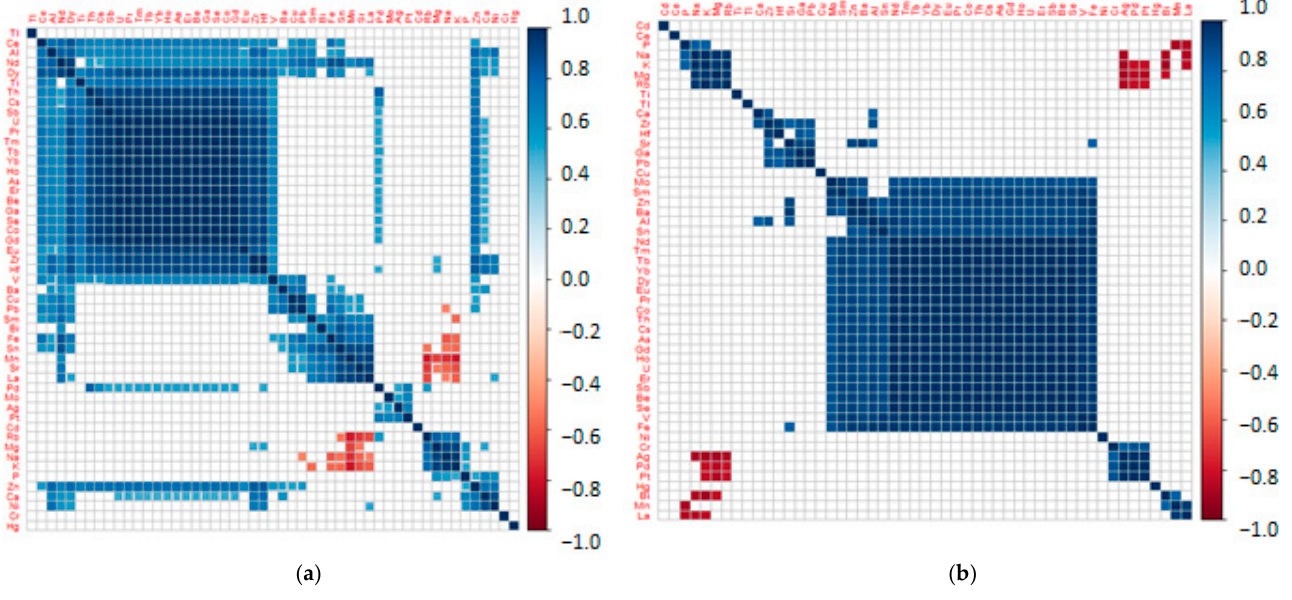
Figure 1. Correlation matrices prepared for the controls ( a ) and cases ( b ).